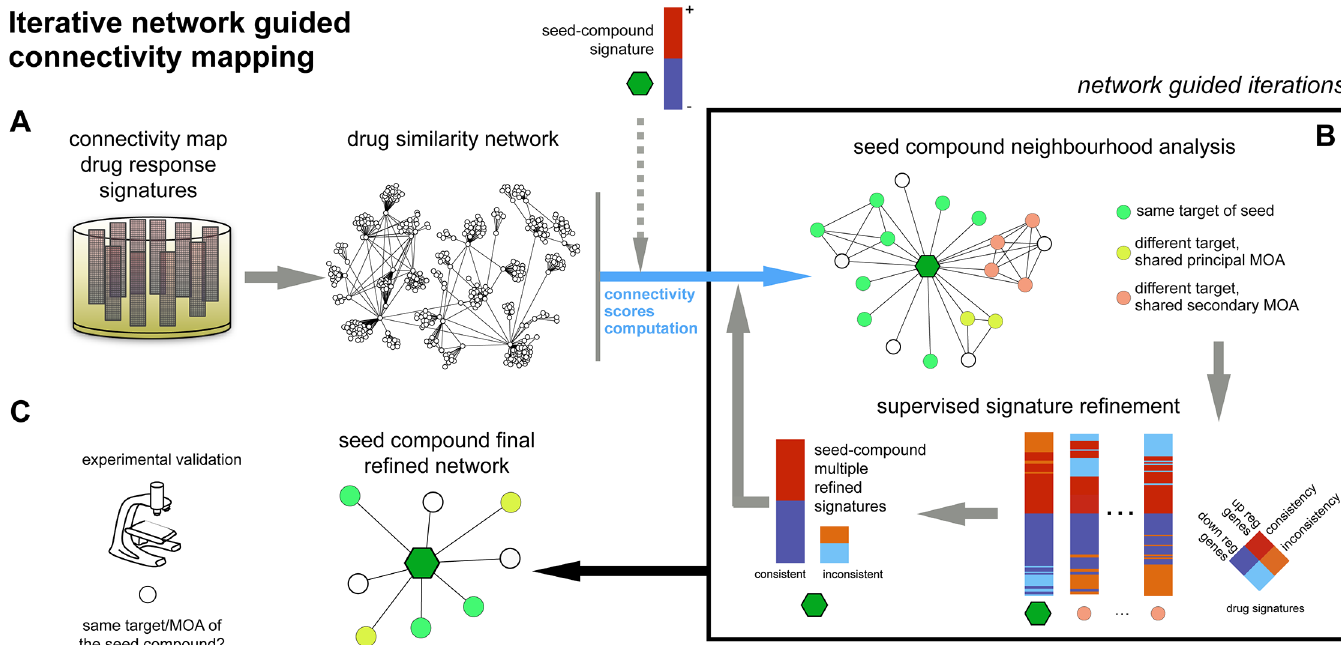
Fig 1. Iterative network guided connectivity mapping pipeline. (A) A drug similarity network (DN) is assembled from the drug response signatures contained in the connectivity-map database; the DN is queried by using the transcriptional signature of a seed compound, composed by up- and down- regulated genes, indicated in red and blue respectively, following treatment with the seed compound. (B) The resulting neighbourhood is analysed. By using a supervised approach the drugs and drug communities connected to the seed compound are investigated for enriched modes of action (MoAs); to dilute effects on drug similarity due to commonalities in secondary MoAs, refined signatures are computed, taking into account inconsistent effects of drug treatment on transcription (i.e. genes up-regulated by the seed treatment and down-regulated when treating with the classes of compounds characterised by the common secondary MoA and vice versa, indicated in orange and cyan respectively). This subdivides the original seed signature into a refined consistent signature and a refined inconsistent signature; the drug network is queried again with the computed multiple refined signatures and resulting connection scores are combined yielding a new seed neighbourhood; (C) after a number of refinement iterations the final neighbourhood of the seed compound is considered as output of the procedure; compounds in the final network, predicted to share the principal MoA of the seed compound, are finally selected for experimental